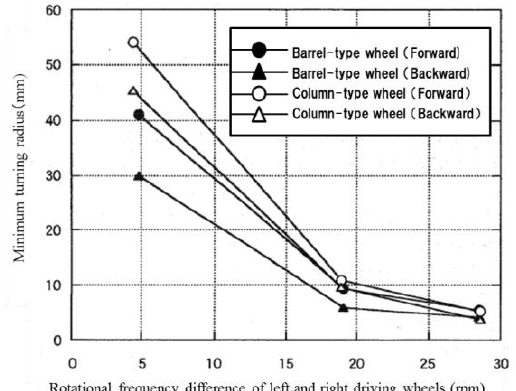
Figure 22. Relationship between the minimum turning radius and the difference of the rotational frequencies of left and right driving wheels (comparison of barrel-type wheel and column-type wheel). The circle marks show the results of forward movement and triangle marks show the results of backward movement. The black marks show the results of barrel-type wheel and white marks show the results of column-type wheel.